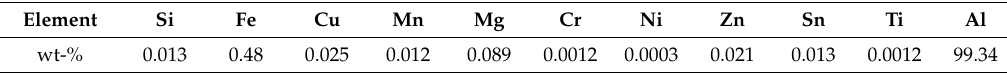
Table 3. Chemical composition of the aluminum alloy (wt-%).